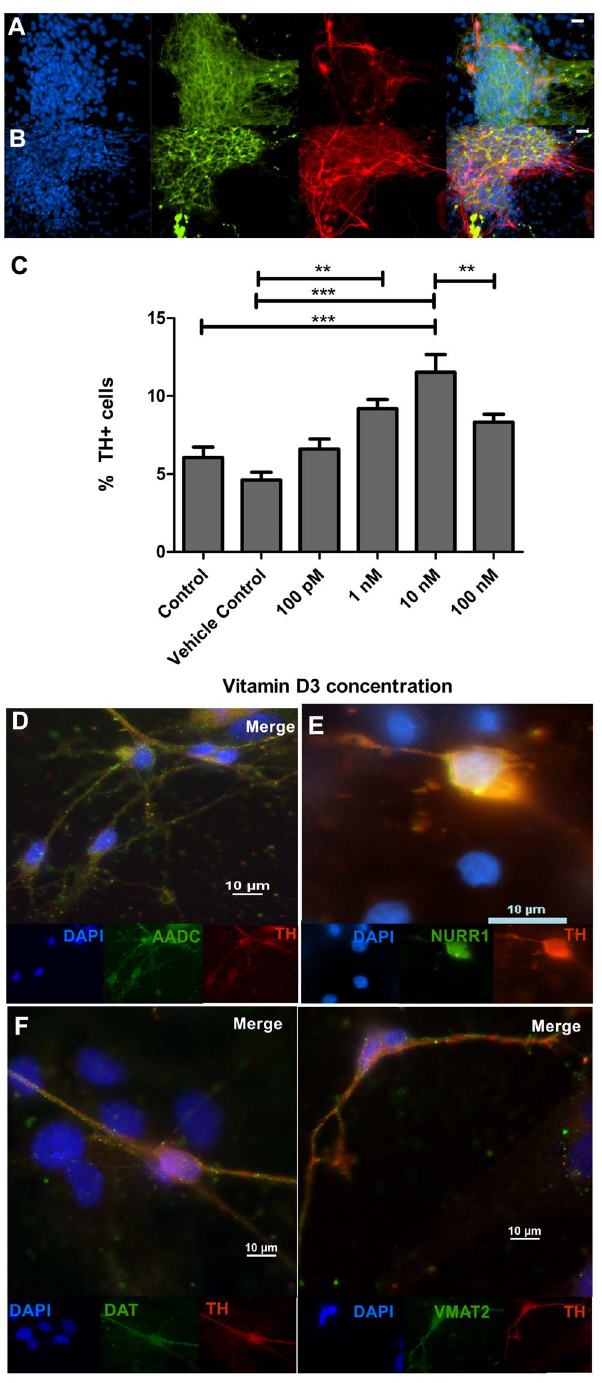
Figure 2. Effect of calcitriol addition to culture media on dopamine neurons. Dose responsive increase in the number of TH immunoreactive neurons was obtained with addition of calcitriol to media. A) primary E12 control cultures and B) cultures with 10 nM calcitriol showing immunostaining with antibodies specific to tyrosine hydroxylase (red) and Tuj1 (green) counterstained with DAPI (blue). Scale bars: 20 m M. C) The percentage of dopamine neurons obtained from cultures with various concentrations of calcitriol added to media. Error bars represent SEM, *** p , 0.001, ** p , 0.01, * p , 0.05. The percentage of dopamine neurons obtained from primary E12 ventral mesencephalic cultures increased when calcitriol was added to media up to an optimum concentration of 10 nM. Dopamine neurons